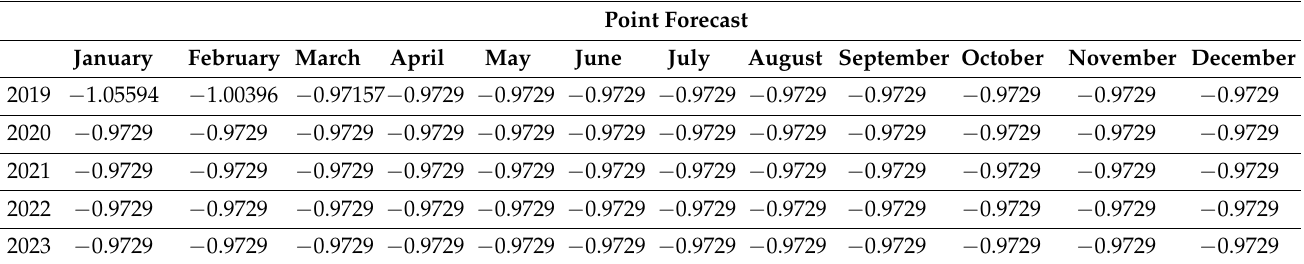
Table 15. Point forecasted value of SPEI-3 for five years. Point Forecast